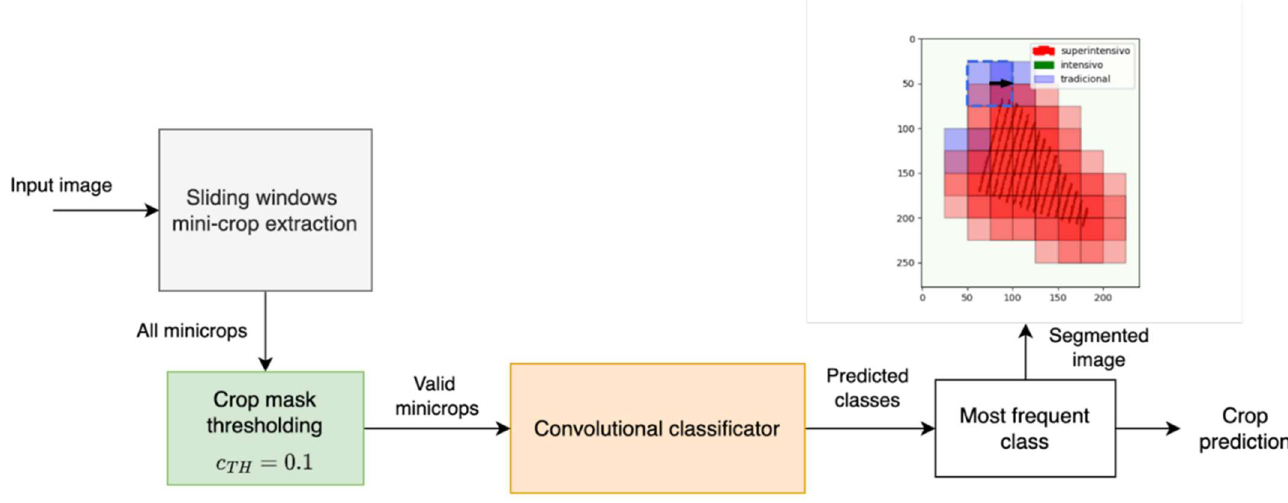
Figure 9. Olive grove farm-level classifier architecture.